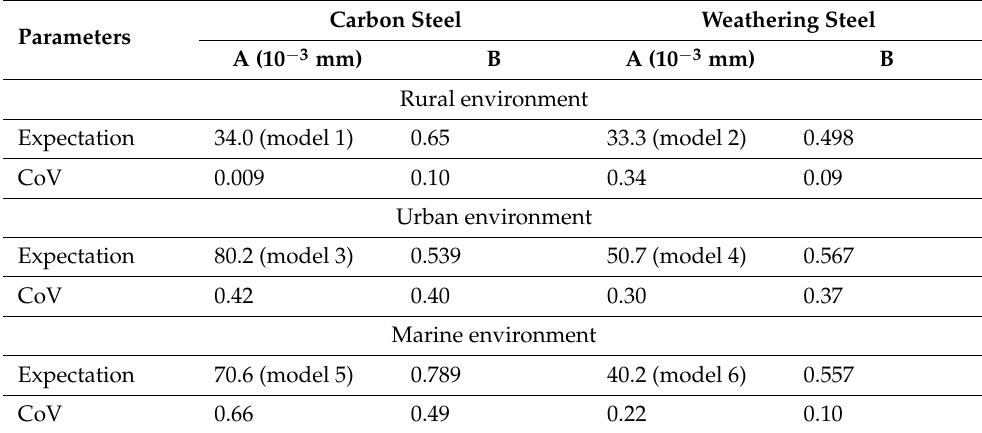
Table 1. Statistical parameters of corrosion for various steel types